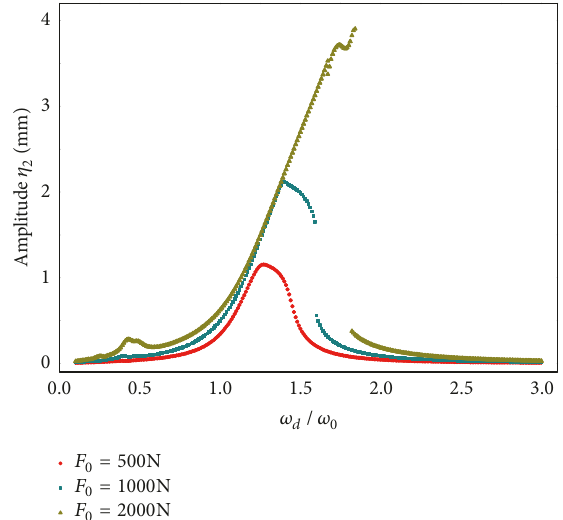
Figure 9: Amplitude-frequency curves related to 𝜂 2 for different excitation amplitudes ( 𝑚 = 1 , 𝑛 = 4 ; Ω = 0.005 ).